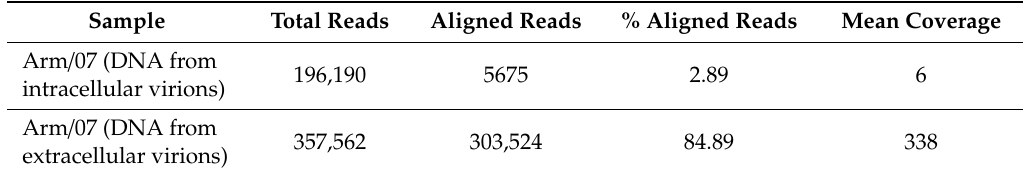
Table 1. Illumina sequencing statistics of African swine fever virus (ASFV) Arm / 07 from viral DNA obtained from either intracellular or extracellular virions.